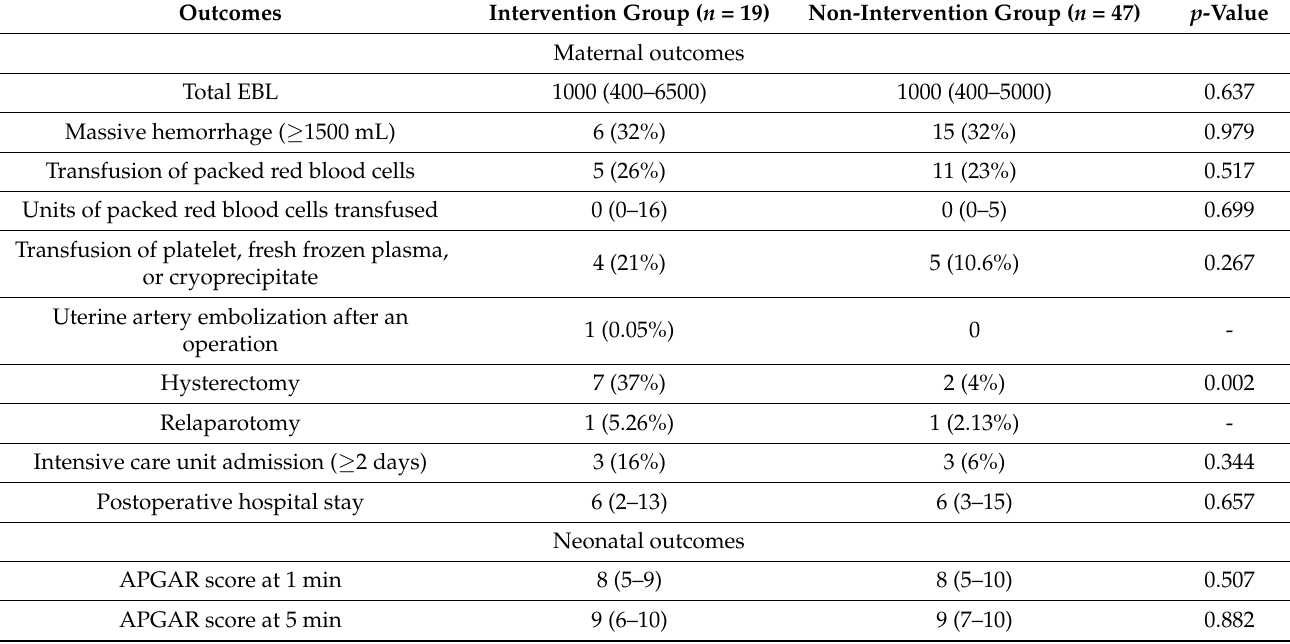
Table 2. Maternal and neonatal outcomes.